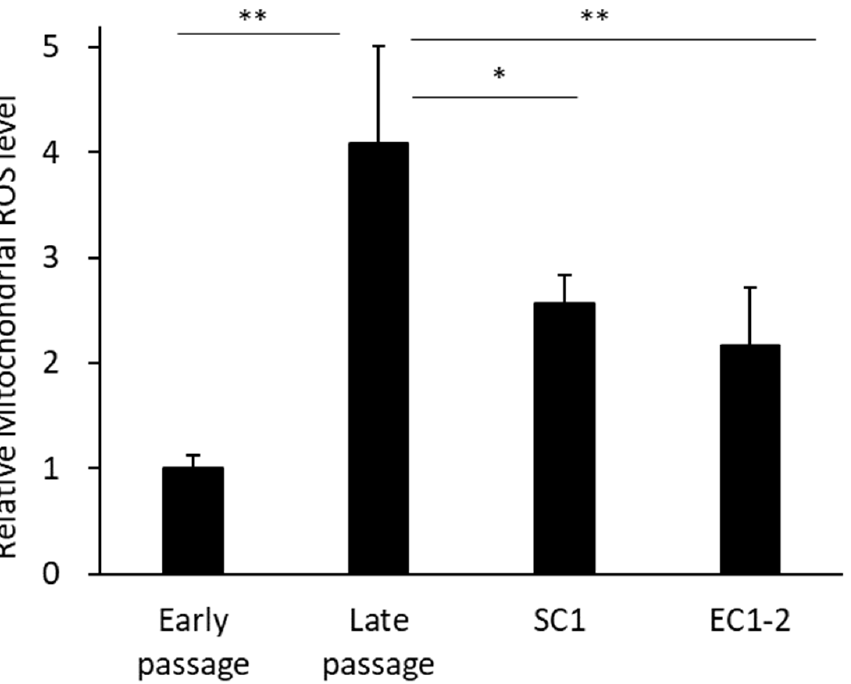
Figure 5. Effects of SC1 and EC1-2 on superoxides in mitochondria. Superoxide production in mitochondria is evaluated with Mito SOX Red staining. Data are reported as means ± SD of three independent experiments. *; p < 0.05, **; p < 0.01 vs. Late passage group by Dunnett’s test.